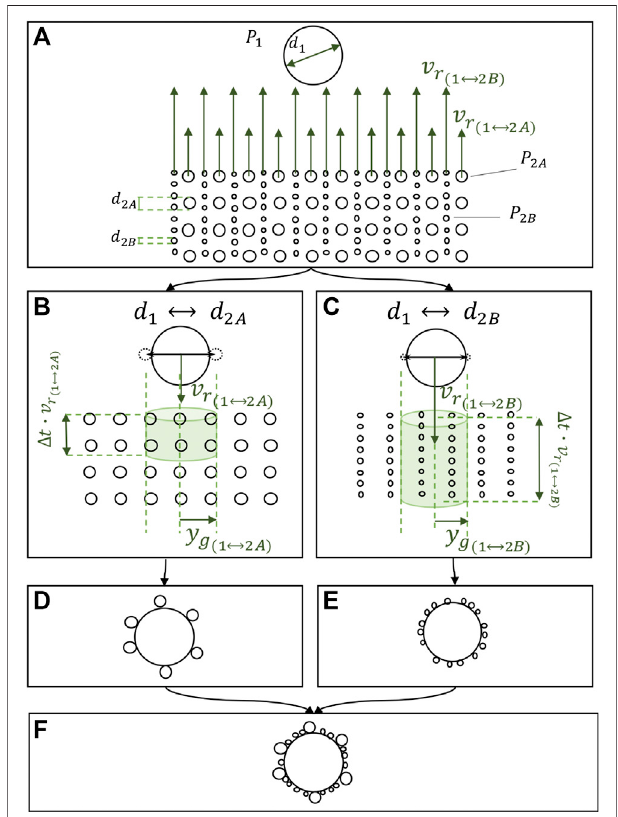
FIGURE 4 | Schematic representation of neutral particles forming a cored cluster. (A) core particle falling through a cloud of smaller particles, characterised by a bimodal grainsize distribution. Velocity vectors are shown in the reference system of the larger particle. (B) swept volumes relative to the interactions between P1 and P2A, (C) swept volumes relative to the interactions between P1 and P2B; in both Figures (B) , (C) , the velocities are drawn with respect to the reference system of P 2 . Figures (D) , (E) show the particles that stick with the core. (F) fi nal cored cluster (i.e. initial core particle surrounded by a variety of particles P2A and P2B).